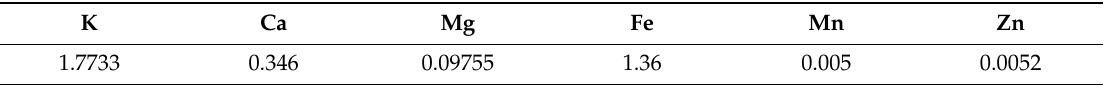
Table 1. Ion composition of the water of the Athens city supply system after a softening process (WSS) estimated via atomic absorption spectroscopy (mg /